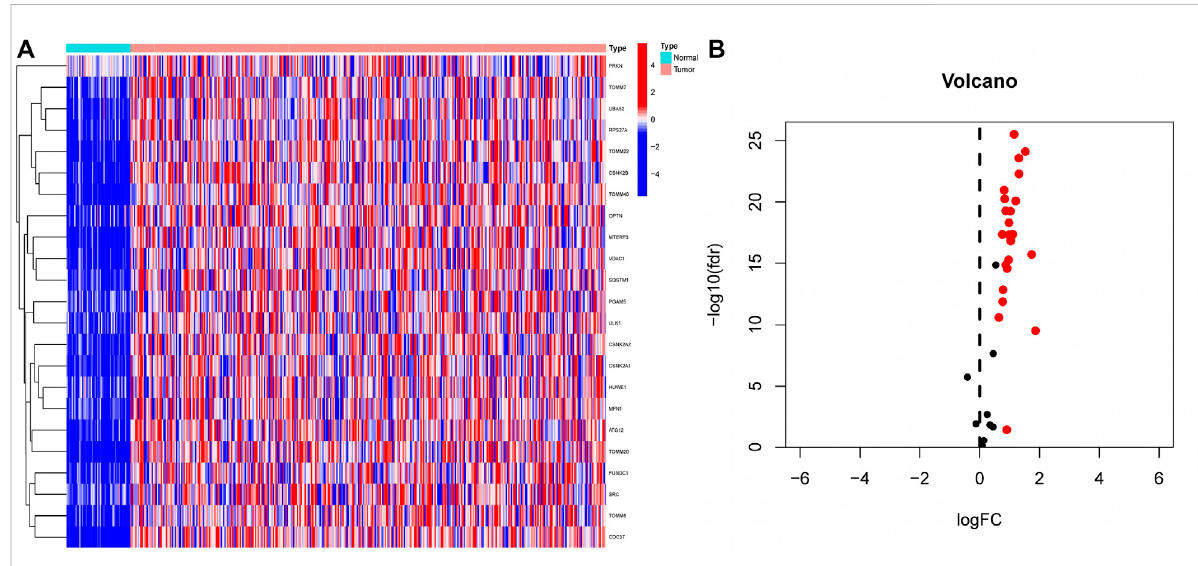
FIGURE 2 Extraction of differentially expressed mitophagy-related genes (A) A total of 23 genes related to mitophagy were differentially expressed between HCC tissues and normal tissues. In the heatmap, the front half of the transverse axis represented normal tissue, and the latter half represented tumor tissue. Red mean high gene expression, blue mean low gene expression; (B) Volcanic map of the expression of thirty-four MRGs in HCC tissues. The expression of red genes was up-regulated in HCC tissues, and the expression of black genes was not signi fi cantly changed in HCC